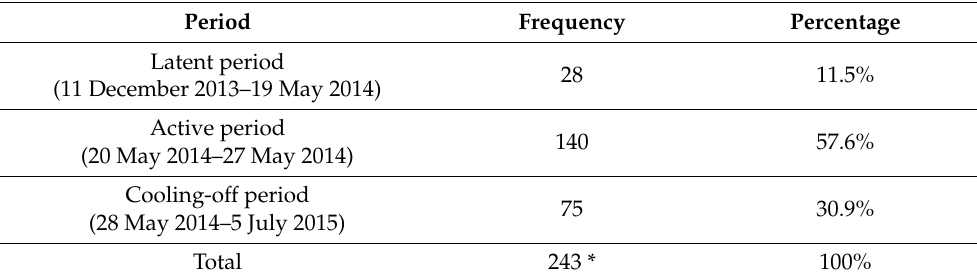
Table 2. Frequency of news coverages and posts across time.